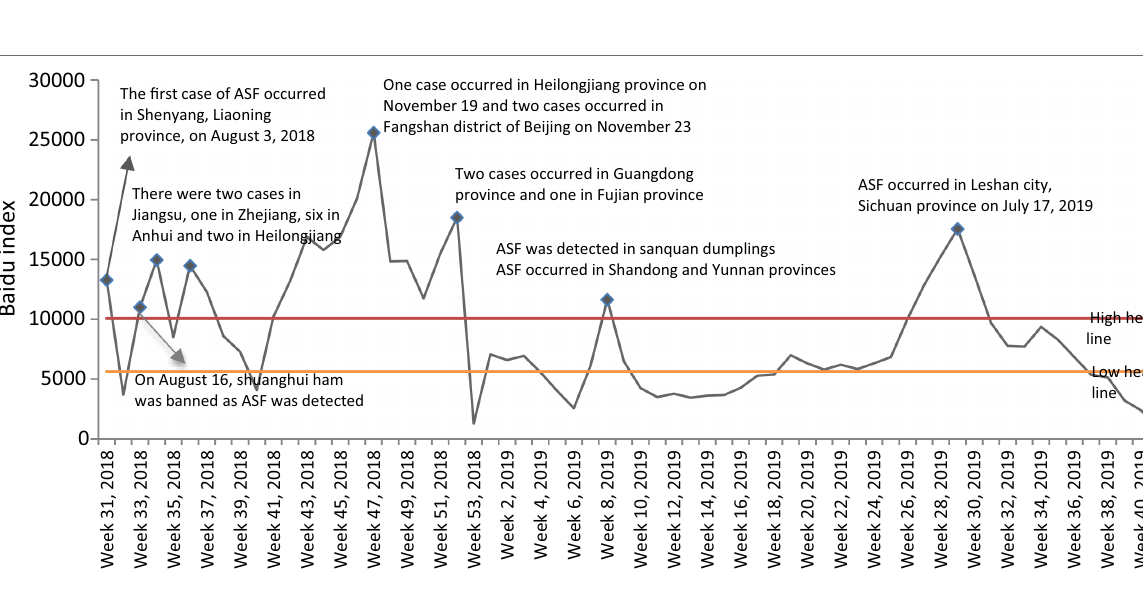
FIGURE 1 | Changes in pork prices in mainland China since May 2018. Data source: China animal husbandry information